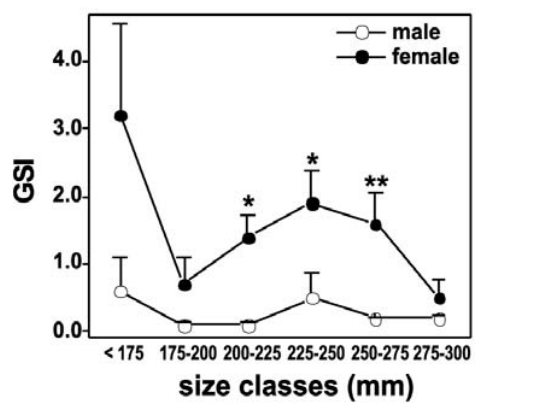
Fig. 3. Means and standard error (vertical lines) for gonadosomatic index (GSI) by sex and size classes for Geophagus brasiliensis in the Lajes Reservoir. Between-sex significant differences: * p < 0.05; ** p < 0.01.